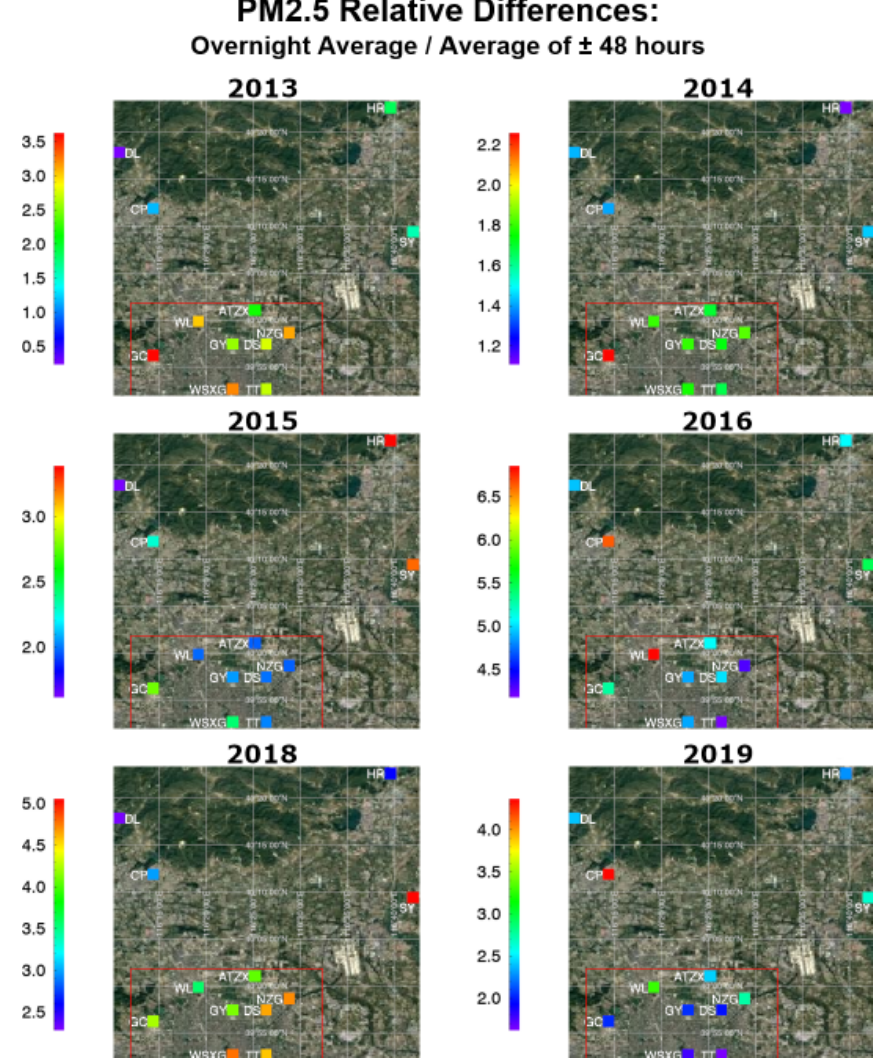
Figure 10. The 12 MEP sites mapped in the Beijing metropolitan area, showing the ratio of overnight PM 2 . 5 observations during the CNY (21:00–05:00) to all data during the period of 48h before through 48h after the CNY. The red line marks the approximate location of the 5th Ring Road. Note that the color bars on each map are relative to only that year, and the color bar range is not the same in different years. The year 2017 is omitted from this figure because data after 00:00 were not available. A list of the sites’ full names in English and Chinese, along with their latitude and longitude coordinates, can be found in Table S1. Imagery: © Google